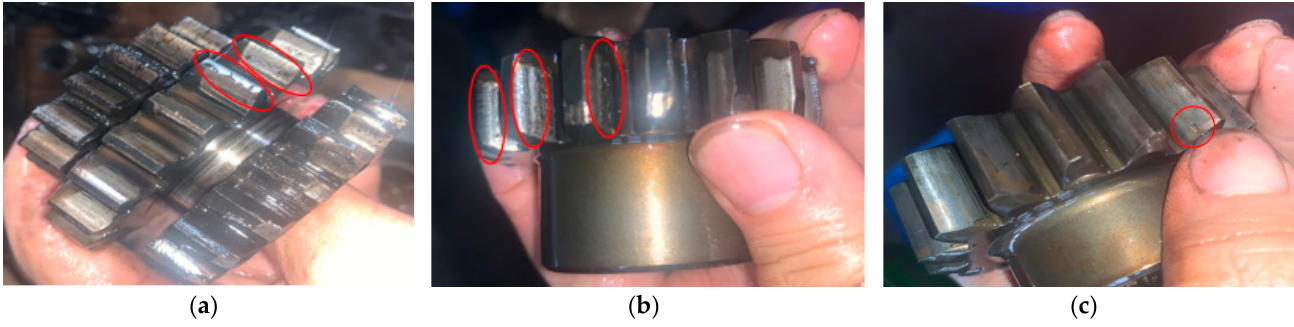
Figure 10. Three-dimension waterfall diagram ( a ) and drawing of partial enlargement ( b ) of differ- ence spectrum of small load in third gear.